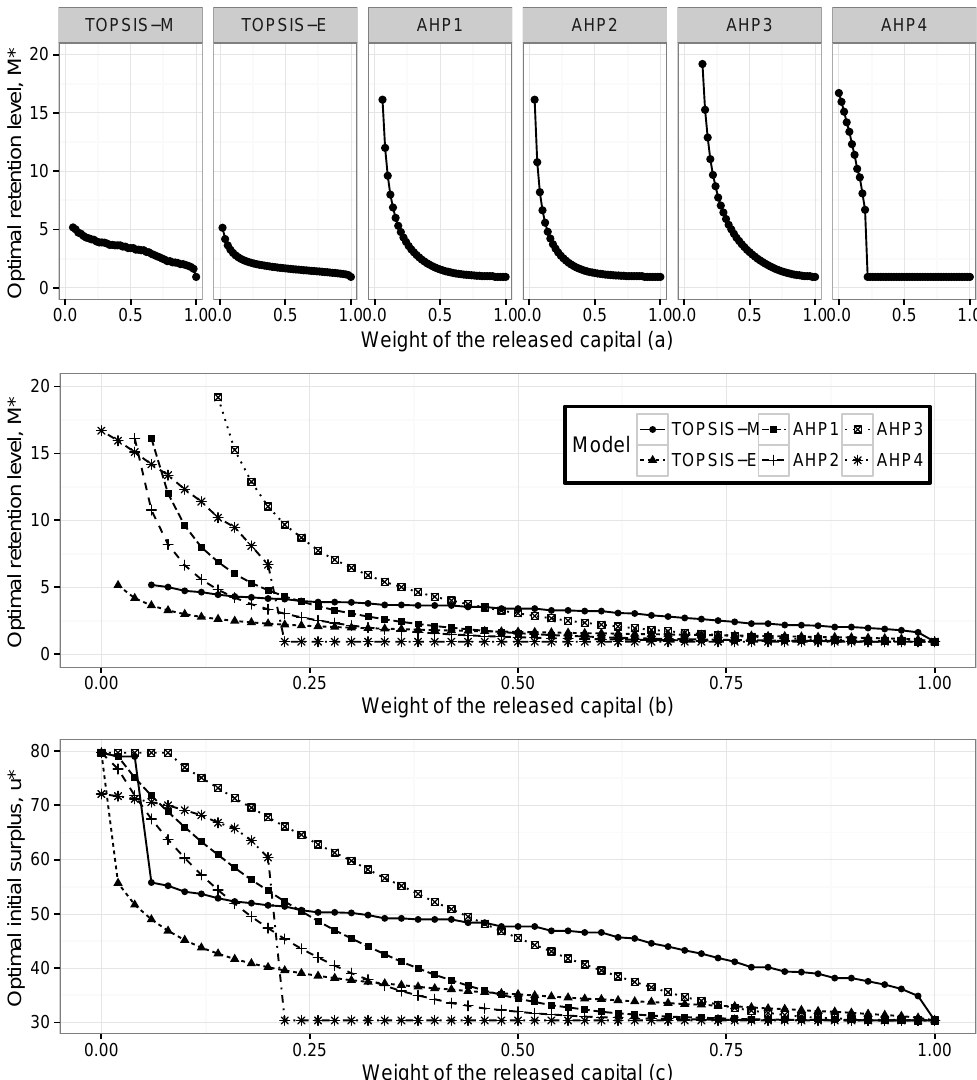
Figure 3. The graph of the optimal initial surplus and optimal retention level when θ = 0.1 and ξ = 0.15 for the Pareto